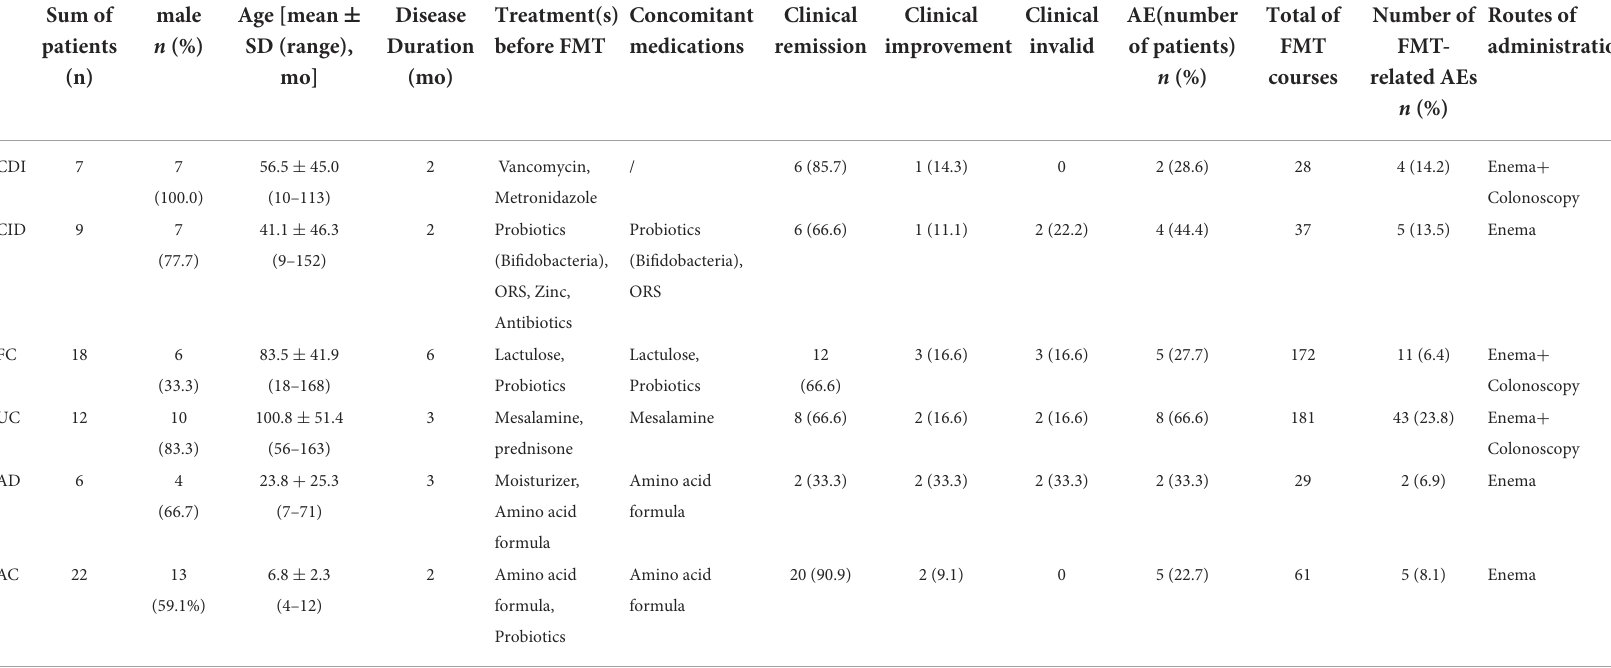
TABLE 2 Clinical information for 74